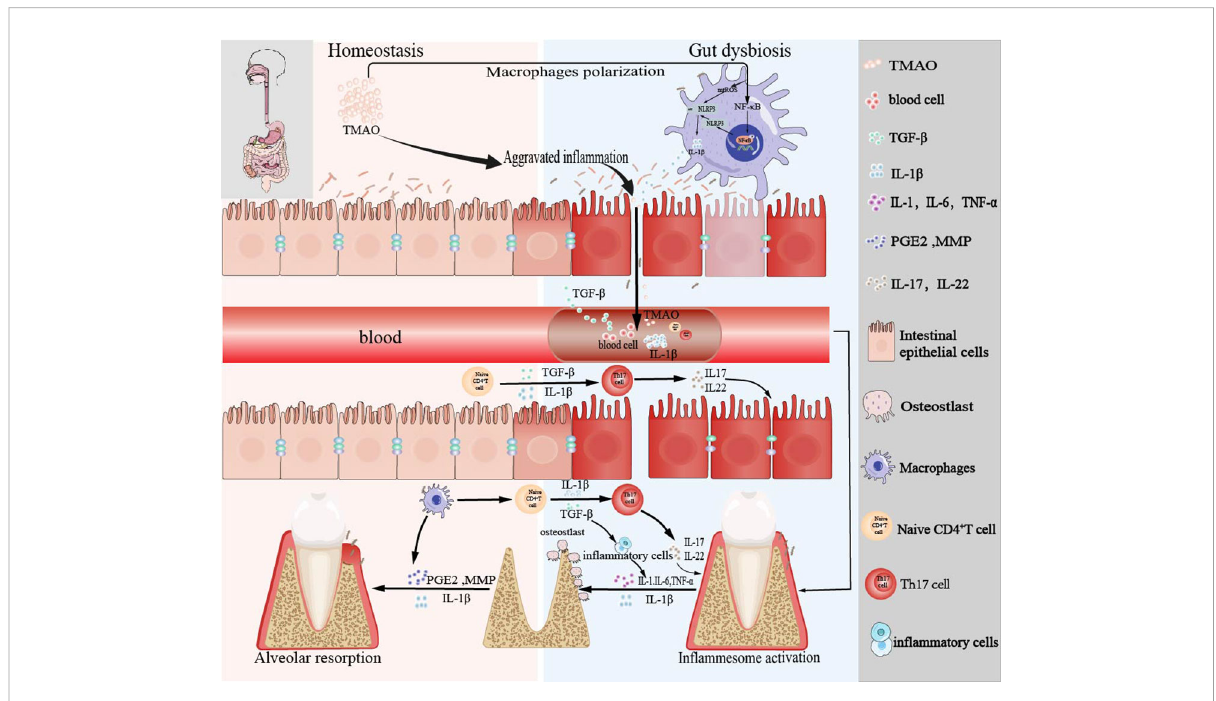
FIGURE 4 Schema of the bidirectional relationship between periodontal and intestinal immunity affected by